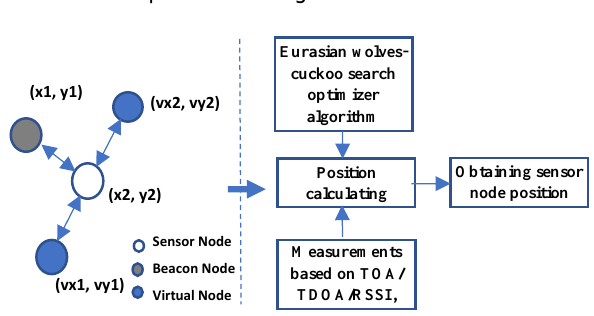
Figure 3. Single beacon-based mobile sensor nodes localization using EW-CSO Algorithm in WSN